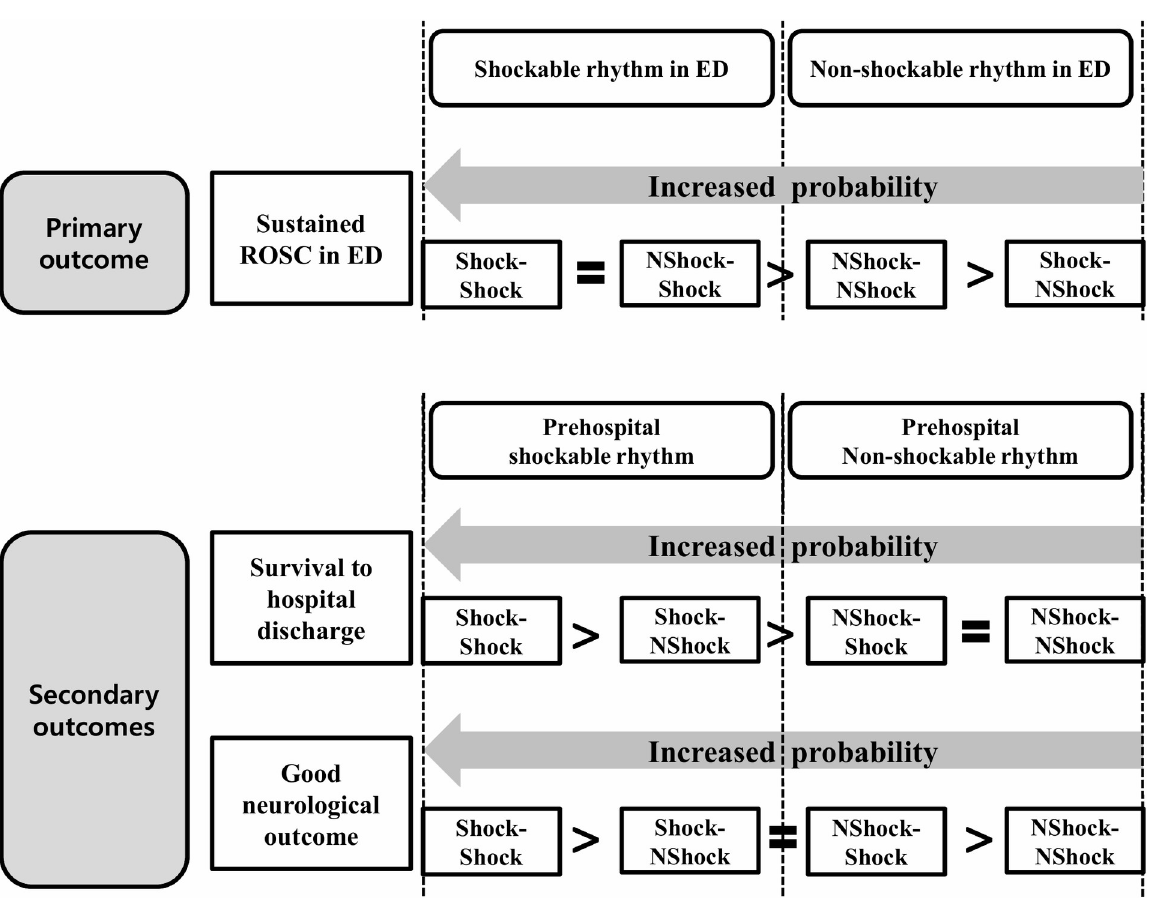
Fig 4. Summarized results of the logistic regression analysis on the effect of changes in the cardiac rhythms from the prehospital to emergency department stages on the outcomes of the OHCA patients without prehospital ROSC after propensity score matching. Shock- Shock, shockable and shockable; Shock-NShock, shockable and non-shockable; NShock-Shock, non-shockable and shockable; NShock-NShock, non-shockable and non-shockable; ROSC, return of spontaneous circulation; ED, emergency department.